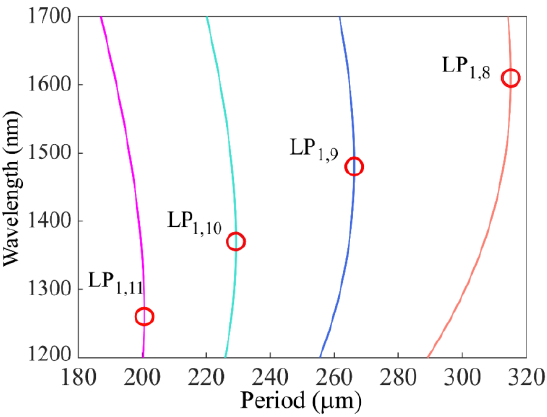
Figure 2. The relationship between resonance wavelength and grating period of four cladding modes.